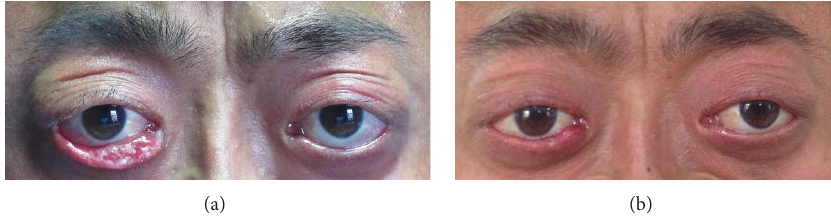
Figure 3: Eyes images. (a) Eyes image before surgery presented sparse eyelashes, multiple rows, or absence of lashes on the upper lids with absence of lash on the lower lids. Right lower eyelid overturned seriously; (b) eyes image at 10-month follow-up showed that right low eyelid keeps the normal